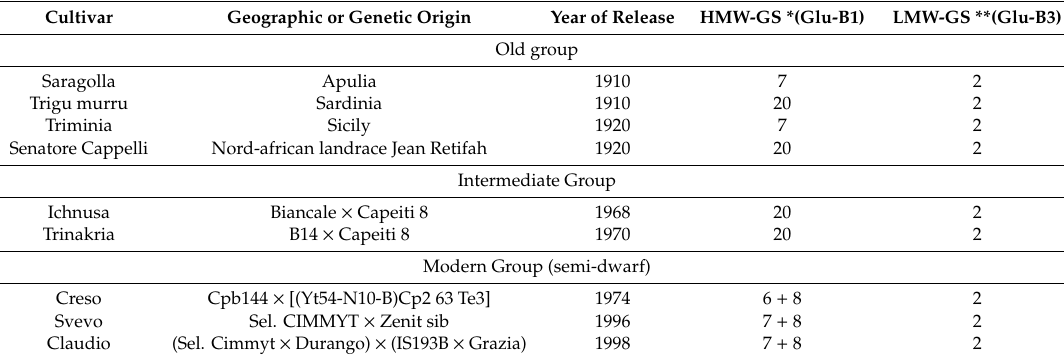
Table 1. Origin, period of release, and gluten subunits of the durum wheat cultivars analyzed.